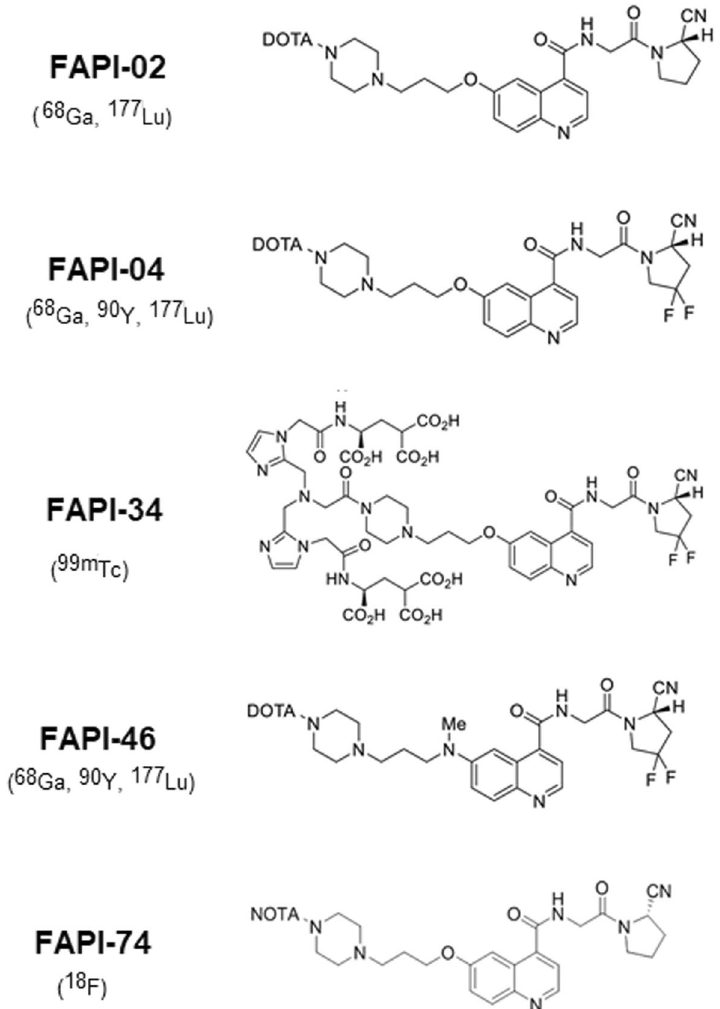
Fig. 1 Chemical structures of FAPI precursors used in clinical application with nuclides in brackets (Lindner et al.